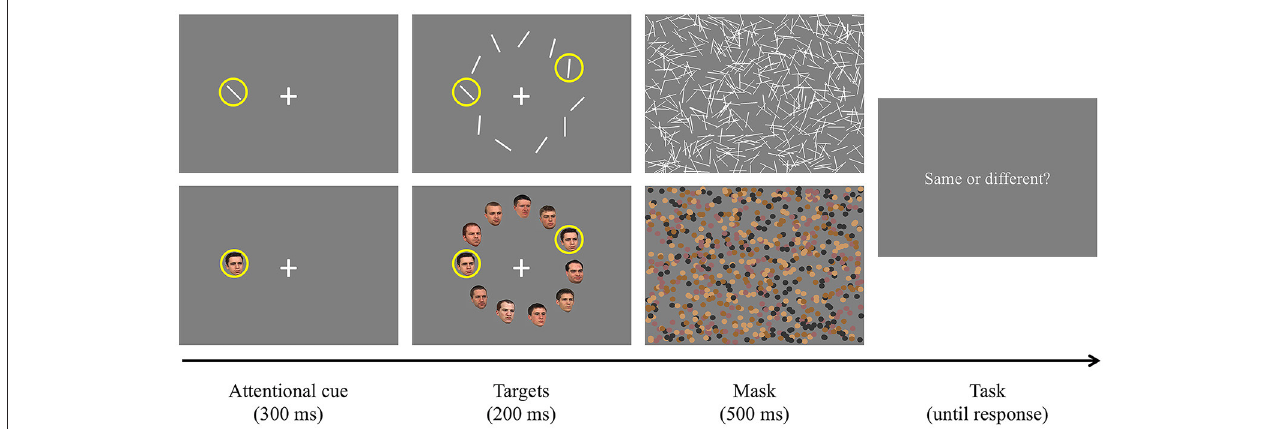
FIGURE 5 | Procedure of Experiment 2. The upper panel shows an example of Experiment 2A (orientation, different targets) and the lower panel shows an example of Experiment 2B (human face, same targets). Unlike Experiment 1, one of the target stimuli surrounded by a yellow ring was presented for 300ms as the attentional cue. Later, the other stimuli were presented for 200ms and another target stimulus was indicated by a yellow ring. They were followed by 500ms masking stimuli. Participants pressed a predetermined key to report whether the targets were the same or different.